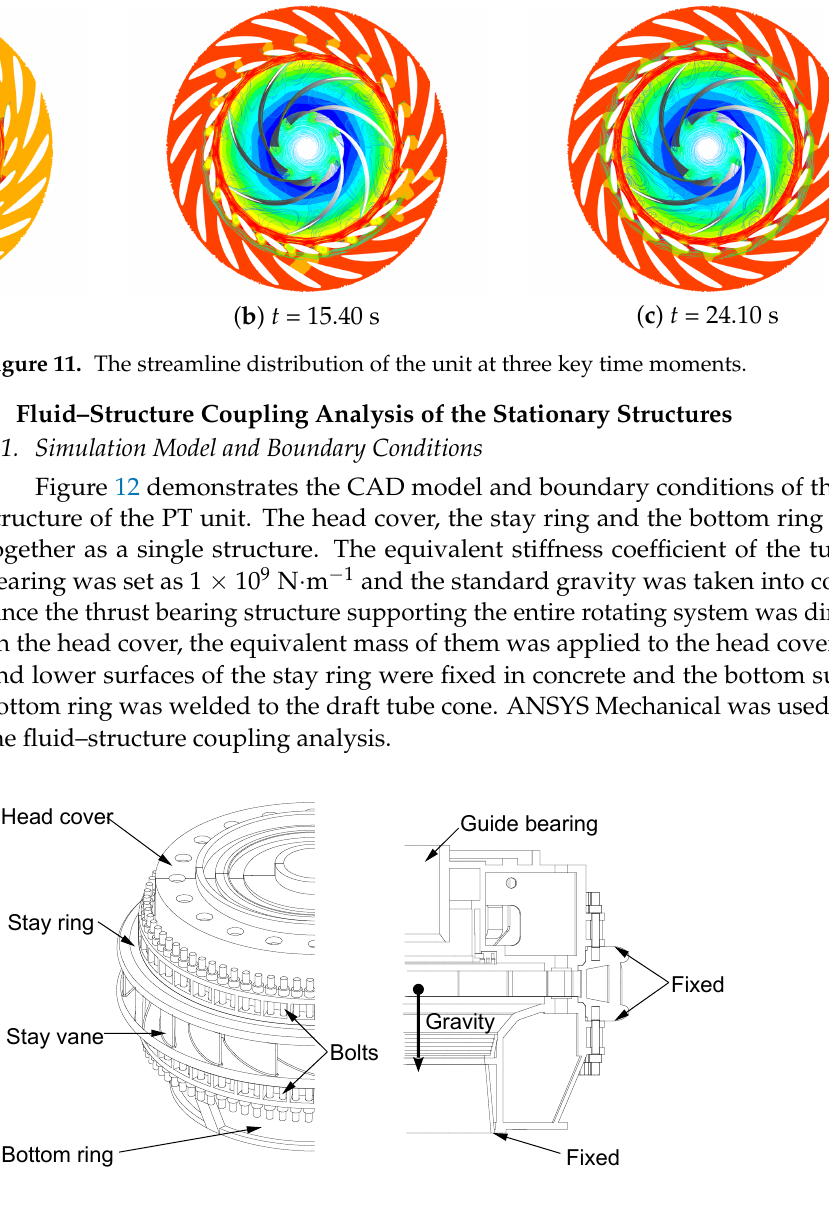
Figure 12. CAD model and boundary conditions of the stationary structures of the PT unit.